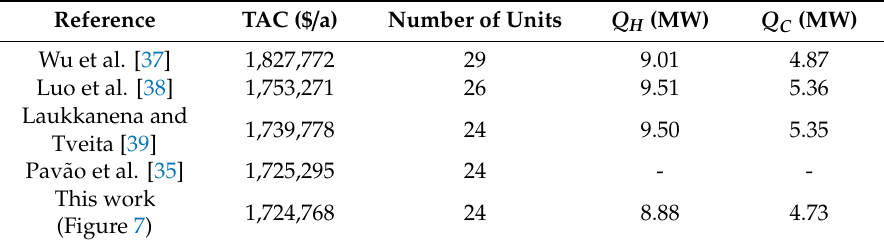
Table 8. Comparison results of case